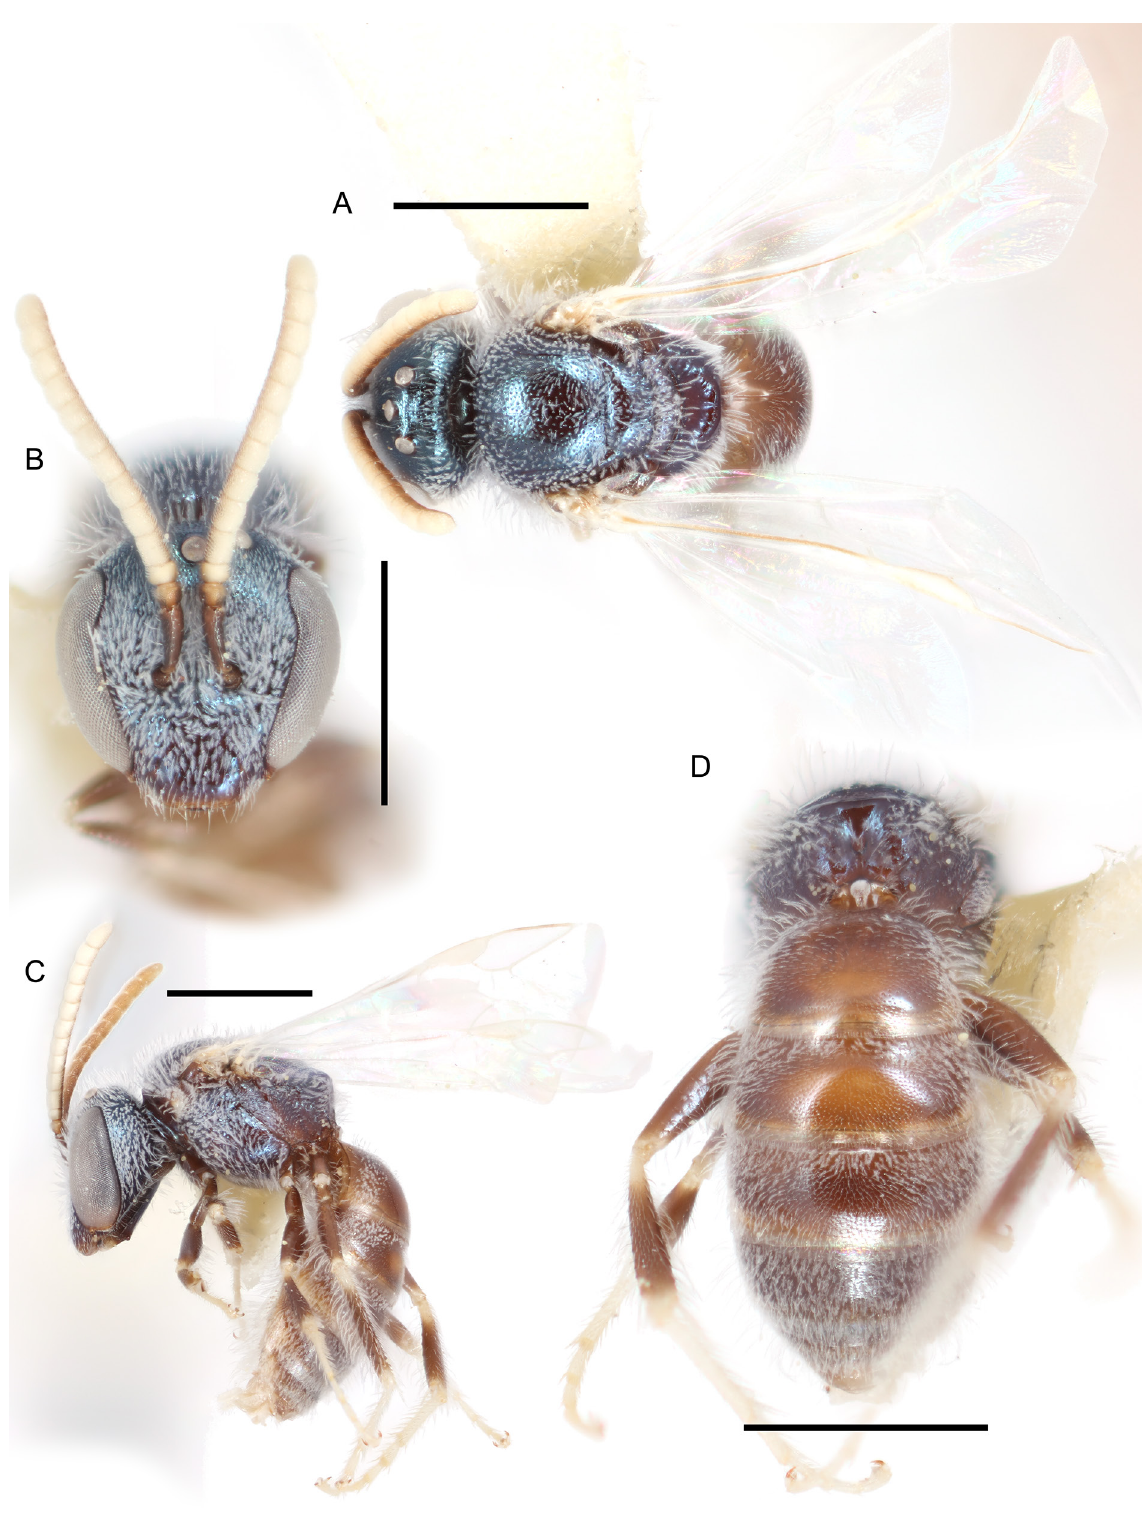
Fig. 76. Lasioglossum ( D. ) rufornatum sp. nov., ♂. A . Dorsal habitus. B . Face. C . Lateral habitus. D . Propodeum and metasoma. Scale bars: 1 178